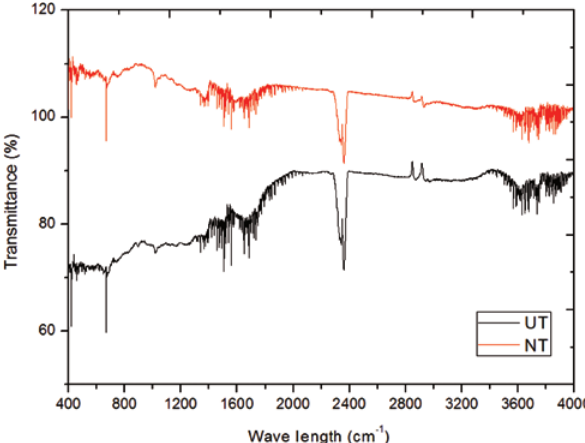
Figure 3 FTIR spectra of untreated and alkali-treated